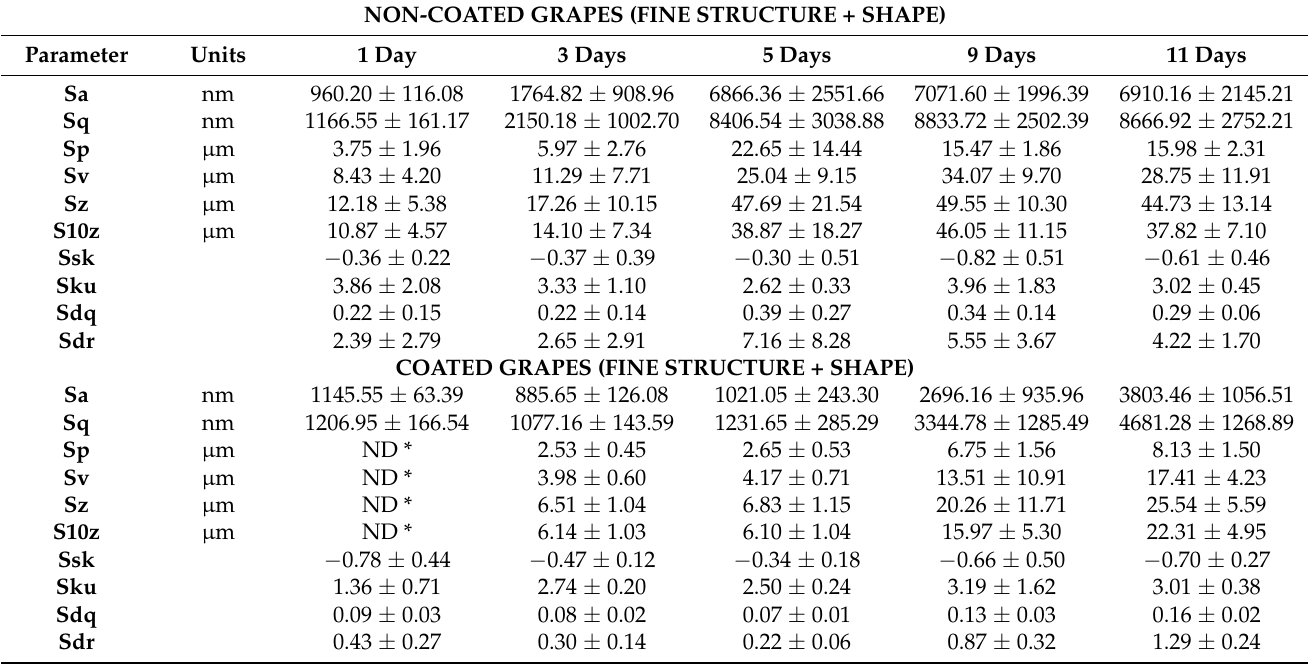
Table 1. Roughness parameters for non-coated and coated grapes without eliminating the shape effect.